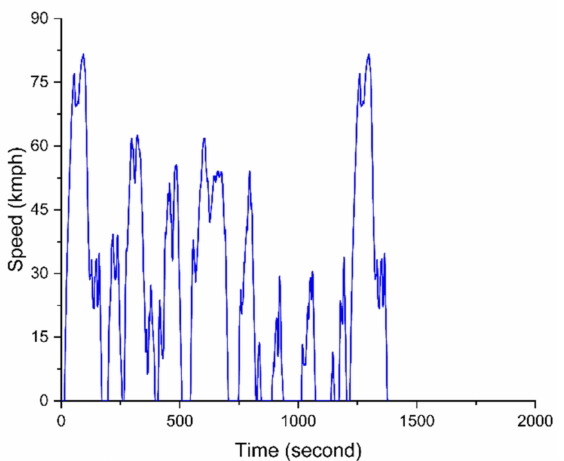
Figure 10. Speed-time profile of the JC08 driving cycle.